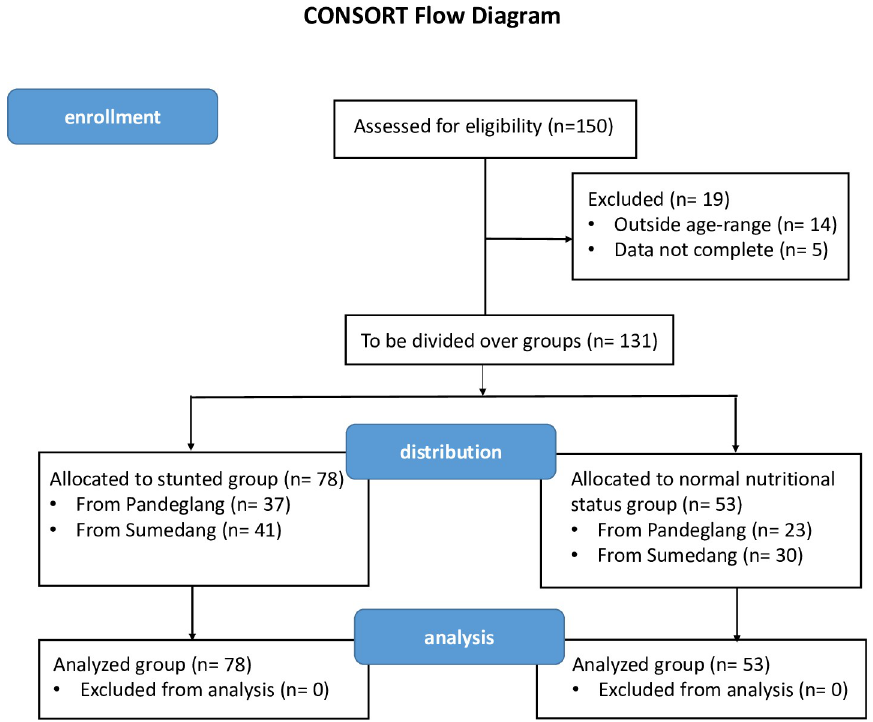
Fig 1. CONSORT flow diagram of the cross-sectional